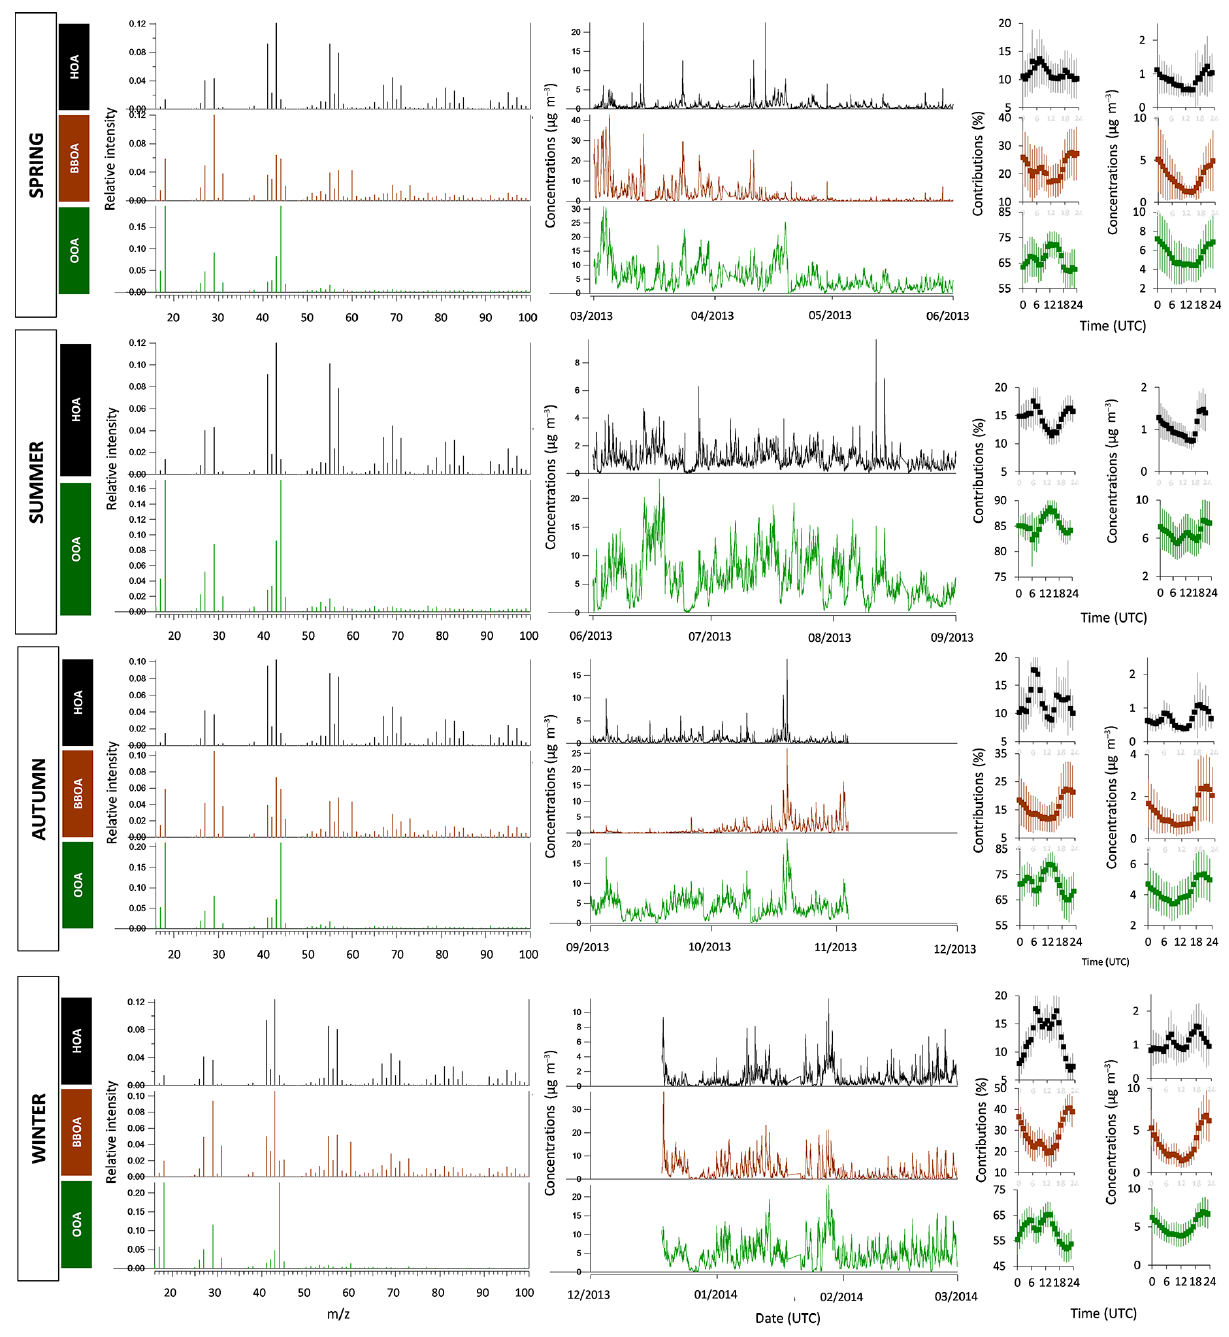
Figure 2. Organic source apportionment presented by season: factor profiles (left), time series (middle) and daily cycles (right, error bars represent 1 standard deviation). Seasons are defined as spring (MAM), summer (JJA), autumn (SON) and winter